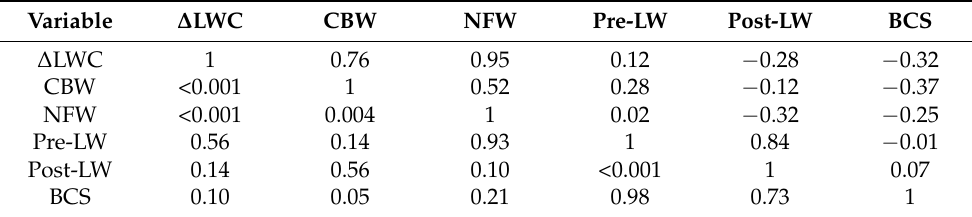
Table 2. Pearson’s correlation matrix between cow liveweight change at calving ( ∆ LWC), calf birth weight (CBW), non-foetal weight (NFW), cow pre-calving liveweight (pre-LW), and cow post-calving liveweight (post-LW). Values above the diagonal are correlation coefficients, with p -values indicated below the diagonal. Variable ∆ LWC CBW NFW Pre-LW Post-LW BCS ∆ LWC 1 0.76 0.95 0.12 − 0.28 − 0.32 CBW <0.001 1 0.52 0.28 − 0.12 − 0.37 NFW <0.001 0.004 1 0.02 − 0.32 − 0.25 Pre-LW 0.56 0.14 0.93 1 0.84 − 0.01 Post-LW 0.14 0.56 0.10 <0.001 1 0.07 BCS 0.10 0.05 0.21 0.98 0.73 1